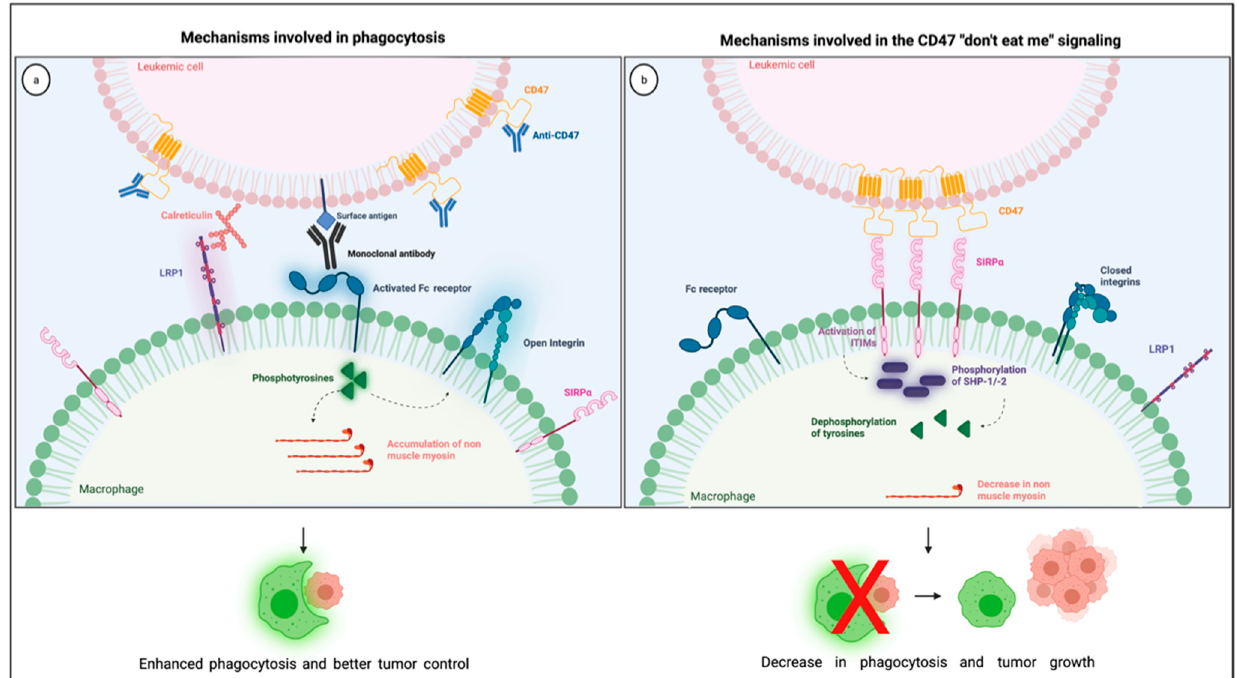
Figure 2. Illustration showing the mechanisms involved in the CD47 blockade and pro-phagocytic signals leading to phagocytosis ( a ) together with the mechanisms involved in the CD47 “don’t eat me signaling” through its interaction with SIRP α in the phagocytic synapse ( b ). Created with Biorender.com.